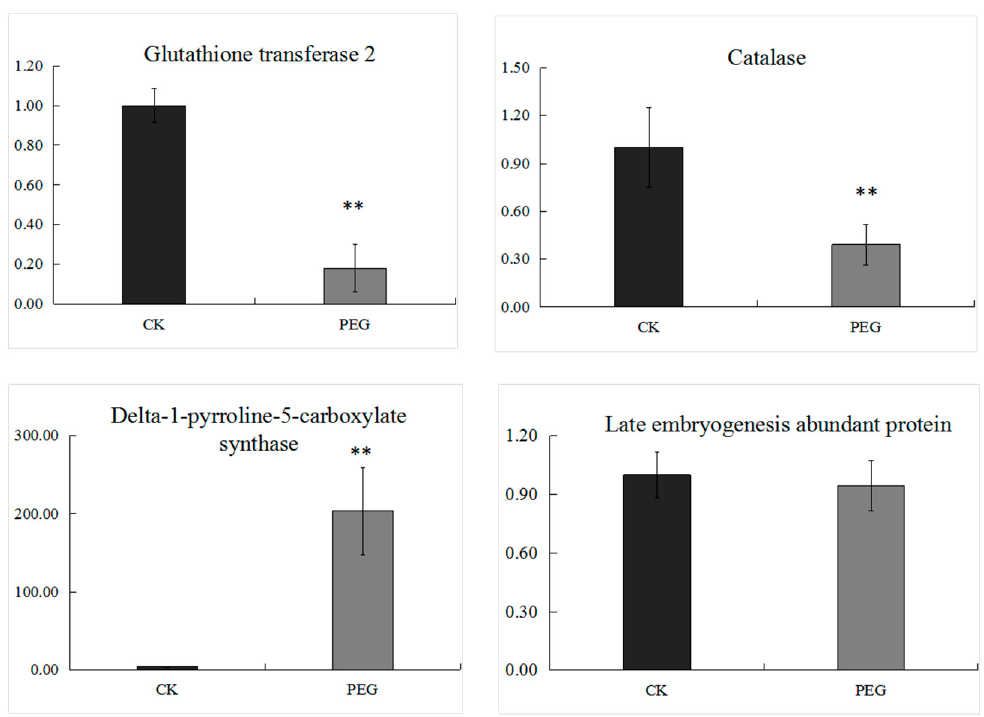
Figure 8. Transcript levels of selected DEPs by qRT-PCR. The data shown here are the mean ± SD of 3 3 biological replicates. ** represents significant di ff erence at p < biological replicates. ** represents significant difference at p < 0.01.